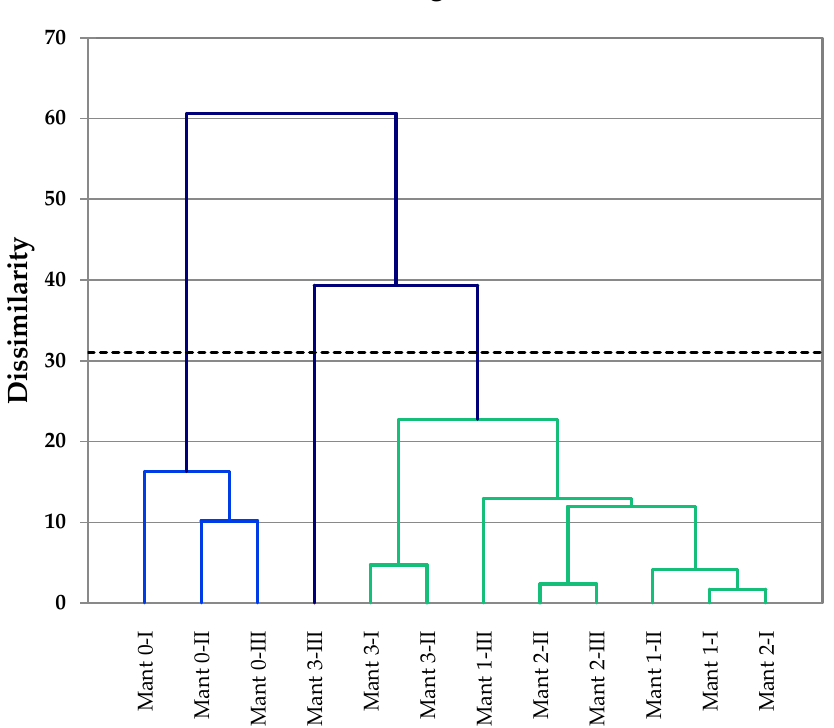
Figure 5. Dendrogram obtained from the hierarchical cluster analysis (AHC). Abbreviations are as follows: Soil samples: Mant 0, control soil (original Vertisol not affected by pedotechnics), while Mant 1, Mant 2 and Mant 3 represent the anthropogenic soils of sites 1 to 3. Depths: I, 0–10 cm; II, 10–30 cm; and III, 30–50 cm.